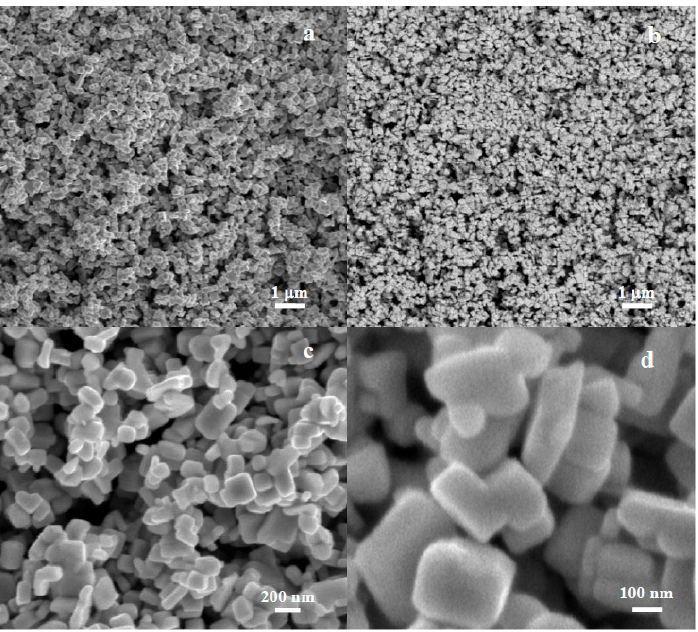
Figure 5. SEM micrographs of CuW3: ( a ) SE and ( b ) BSE images taken simultaneously from the same region; ( c , d ) higher resolution SEM micrographs showing the CuWO 4 platelets size and shape.